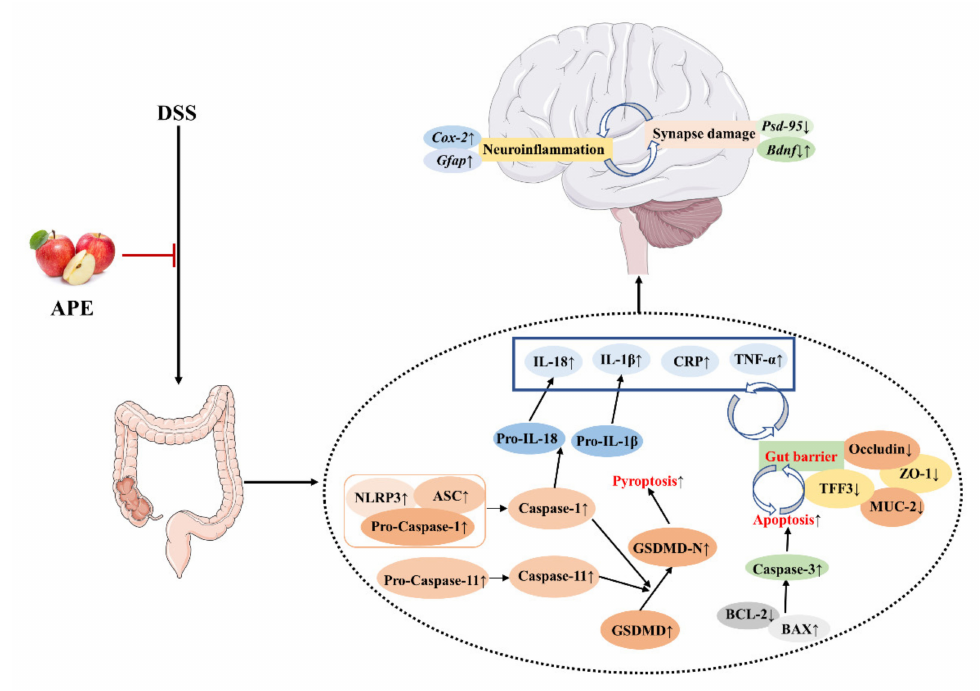
Figure 9. Potential mechanisms that APE protected in DSS-induced acute UC in C57BL/6 male